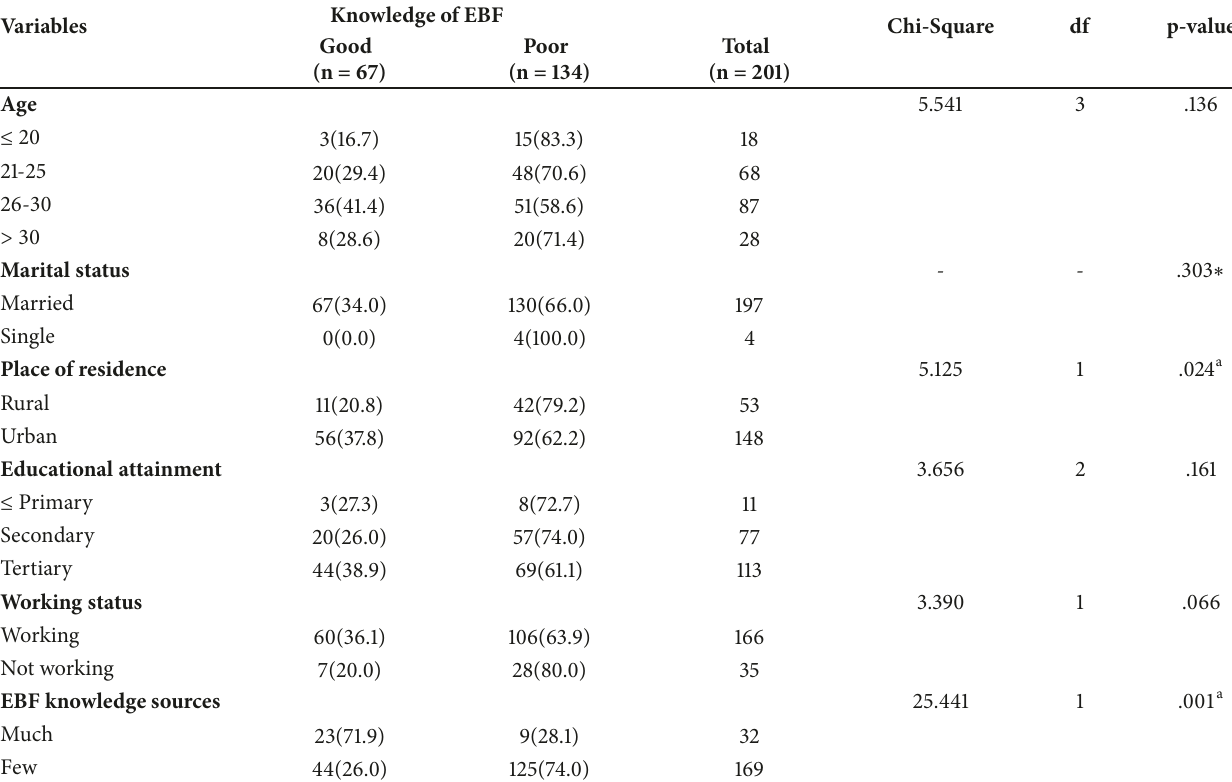
Table 4: Chi-square test of association between demographic variables and EBF knowledge (n = 201).